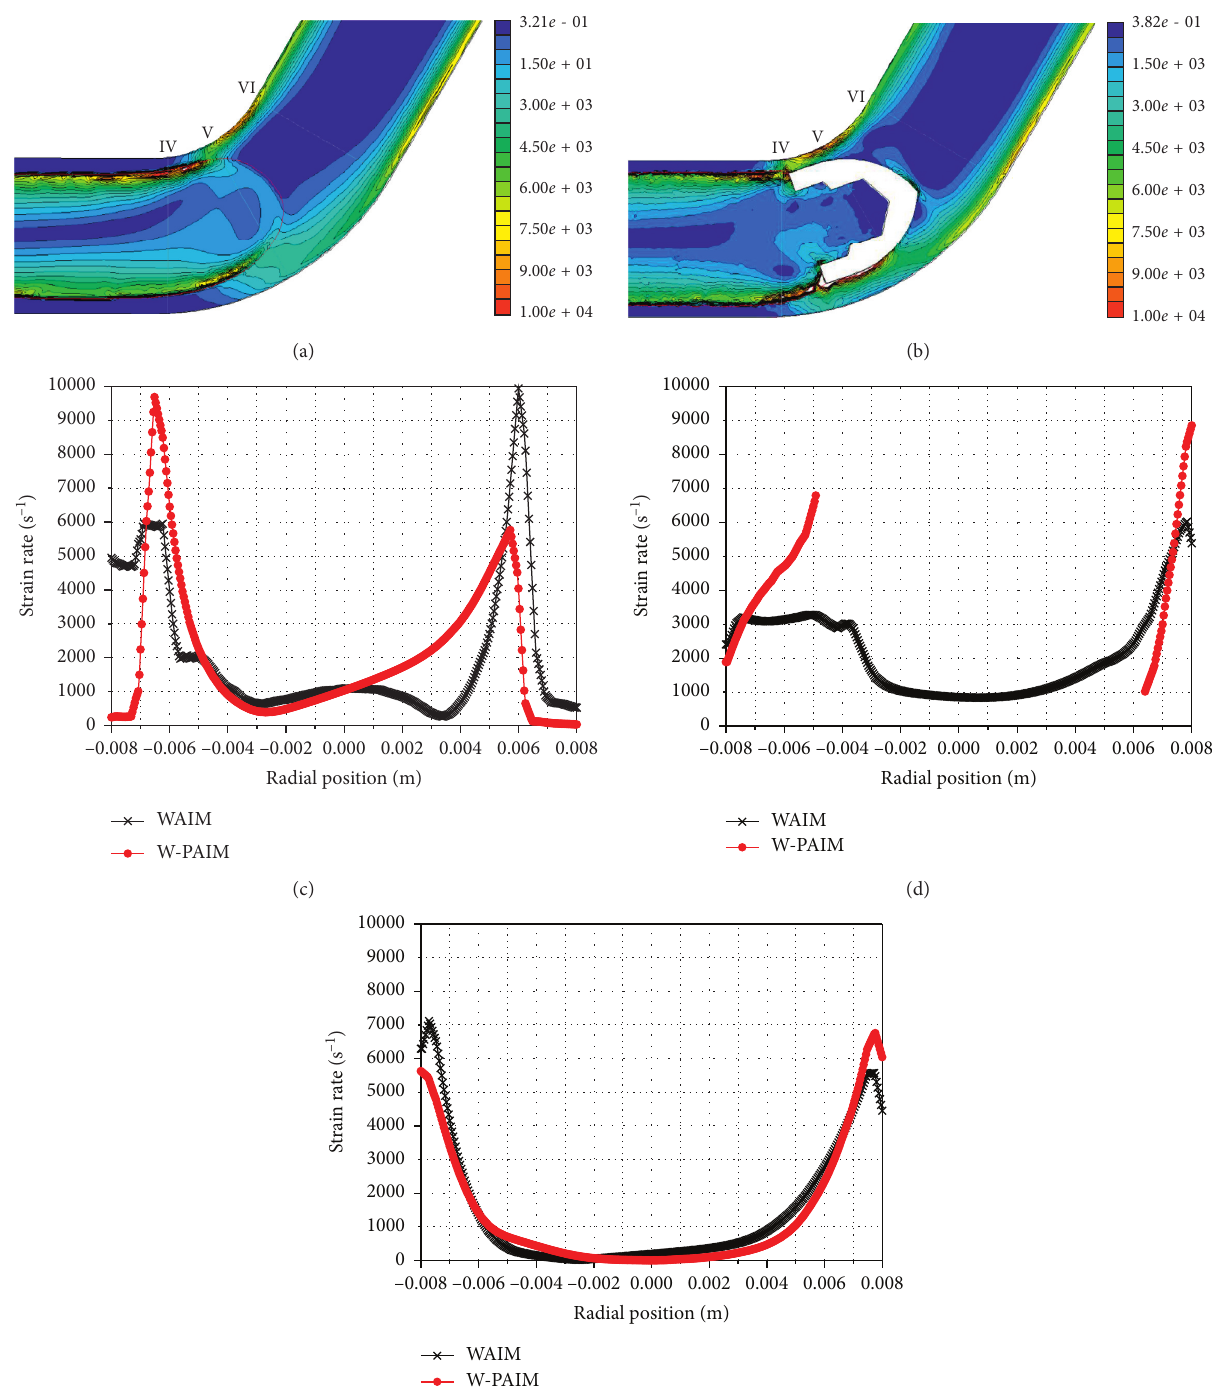
Figure 11: Comparison of the straight rate distribution near the penetration front at the middle location of curved segments between WAIM and W-PAIM: (a) straight rate magnitude contour of WAIM, (b) straight rate magnitude contour of W-PAIM, (c) velocity profiles at position IV, (d) straight rate profiles at position V, and (e) straight rate profiles at position VI (IV, V, and VI denote the beginning, middle, and end of the curved segments, respectively. Negative radial positions are near the outer convex side of curved segments, while the positive radial positions are near the inner concave